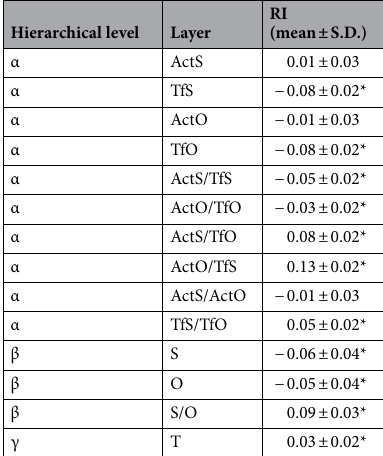
Table 4. Reciprocity index (RI) in the multiplex network. Asterisks indicate significant values ( p value < 0.05, Bonferroni corrected).